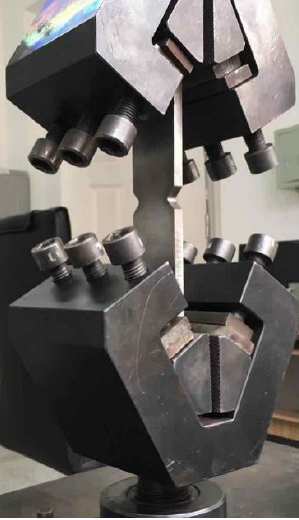
Figure 6. High-frequency fatigue testing fixture with specimen.